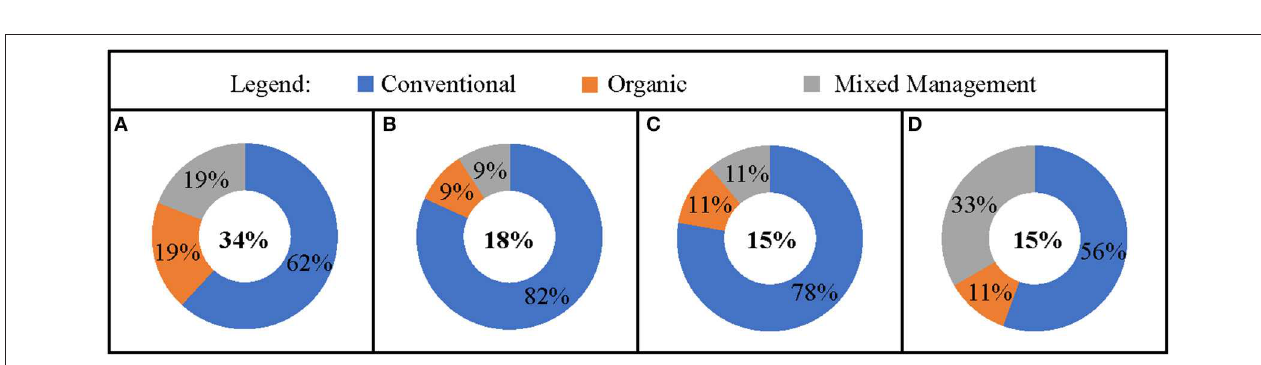
FIGURE 6 | Producers’ perception of the North American consumer. Total percentage (center) and the proportion of conventional, organic, and mixed management producers that reported their perceptions of the North American consumer with respect to their views and knowledge of lentils including (A) nutrient benefits, (B) find taste desirable, (C) how to incorporate lentils in diet with nutritional balance, and (D) how cook with lentils ( p = 0.0323) ( n =